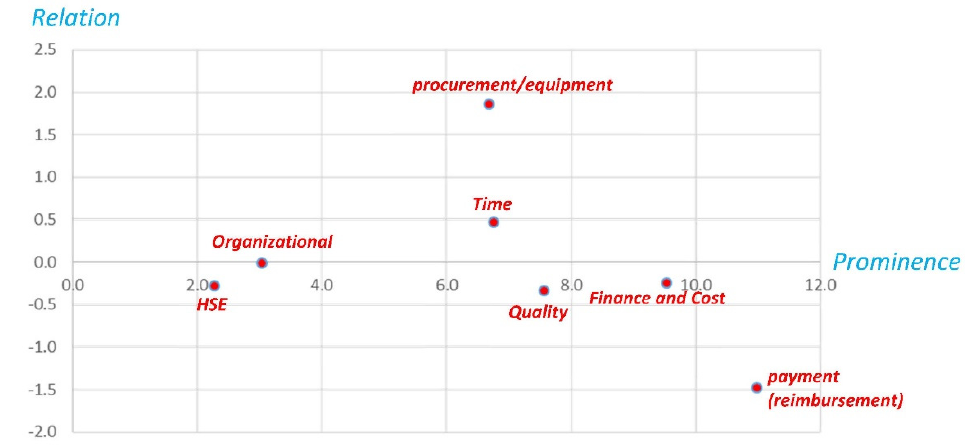
Figure 5. Causal diagram of seven most-frequent factors.